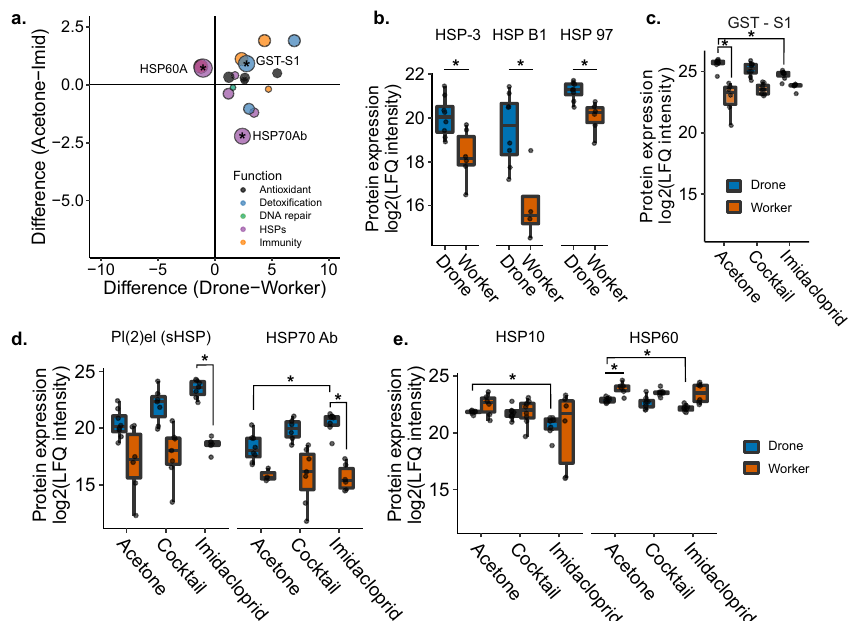
Fig. 4 Differentially expressed proteins linked to stress responses to pesticides. a Proteins differentially expressed between drones and workers which have functions linked to oxidative stress, detoxi fi cation, DNA repair, the heat-shock response, and immunity. Asterisks indicate that the protein was also differentially expressed in drone imidacloprid vs. control comparisons. Boxes represent the interquartile range, bars indicate the median, and whiskers span 1.5 times the interquartile range. Circle size is proportional to − log( p value) for the drone imidacloprid vs. acetone comparison. b Patterns of expression for HSP cognate 3, HSP beta 1, and 97 kDa HSP in drones and workers. Asterisks indicate that the comparison was signi fi cant at 5% global FDR (Benjamini Hochberg). c Pattern of expression of an uncharacterized protein best matching glutathione-S-transferase S1 in Drosophila melanogaster across pesticide treatments. Asterisks indicate that the comparison was signi fi cant at 5% global FDR (Benjamini Hochberg). d Patterns of expression of protein lethal (2) essential for life (Pl(2)el) and HSP70 Ab across pesticide treatments. Asterisks indicate that the comparison was signi fi cant at 5% global FDR (Benjamini- Hochberg). e Patterns of expression of 10 kDa HSP and HSP60, mitochondrial HSPs which are known to physically interact in a 1:1 stochiometric ratio. Asterisks indicate that the comparison was signi fi cant at 5% global FDR (Benjamini – Hochberg). Underlying data can be found in Supplementary Data 4, and summary statistics of these data are in Supplementary Data 5.